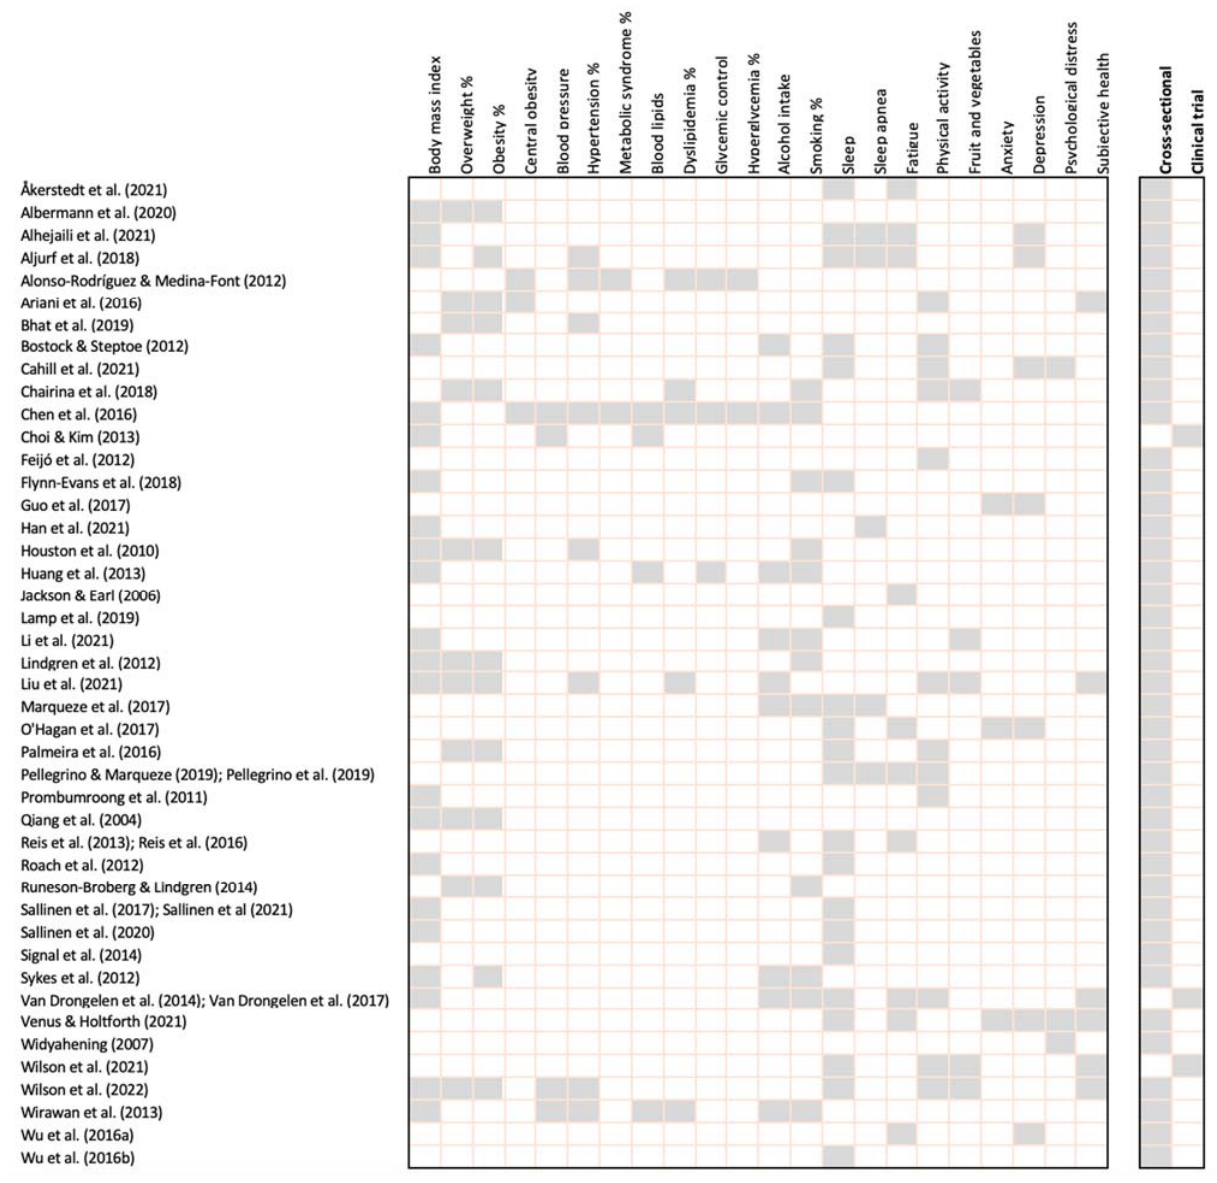
Figure 2. Cardiometabolic risk markers and airline pilot outcome summary for each study. Table 2. Methodological quality scores of cross-sectional